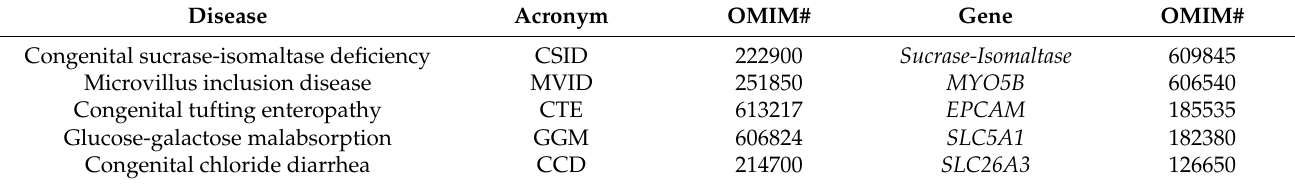
Table 1. Congenital diarrheal disorders and corresponding disease-genes analyzed in the present study.